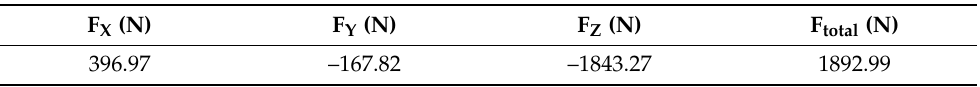
Table 1. Final force values in the femur-based coordinate system transferred from the iterative FEA study to experimental testing.